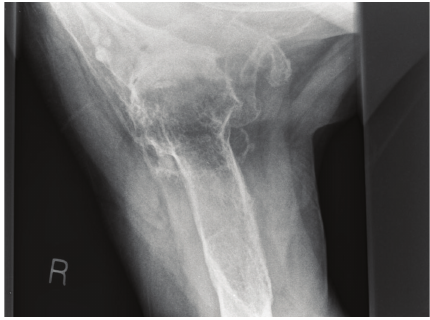
Figure 2: Axillary lateral radiograph of the right shoulder taken pre-operatively.